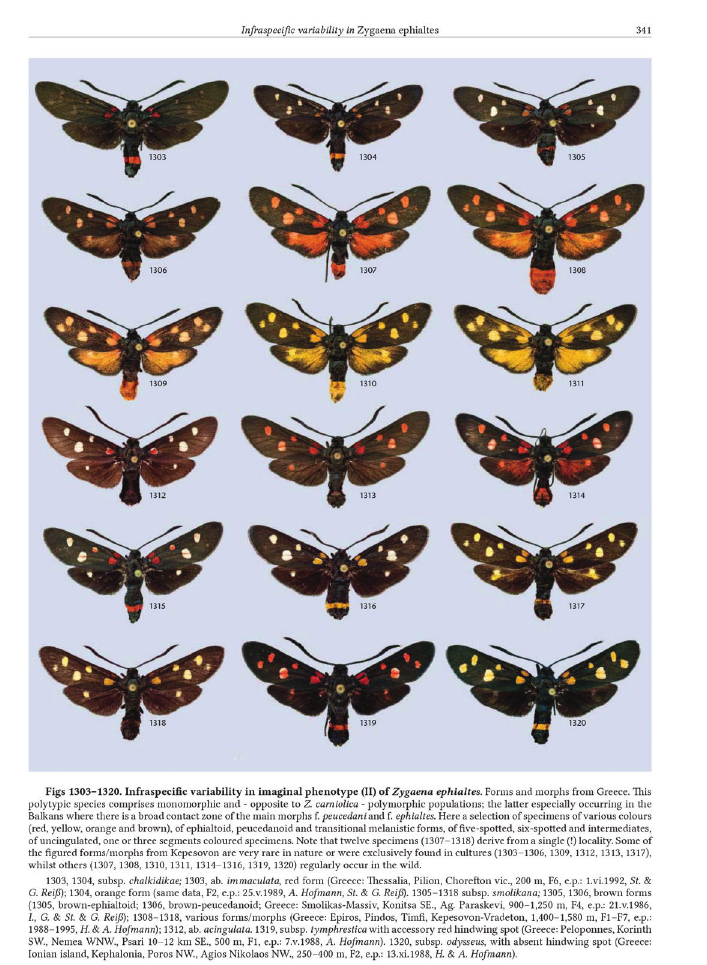
Figure 5. Infraspecific variability in burnet moths on page 341 of the